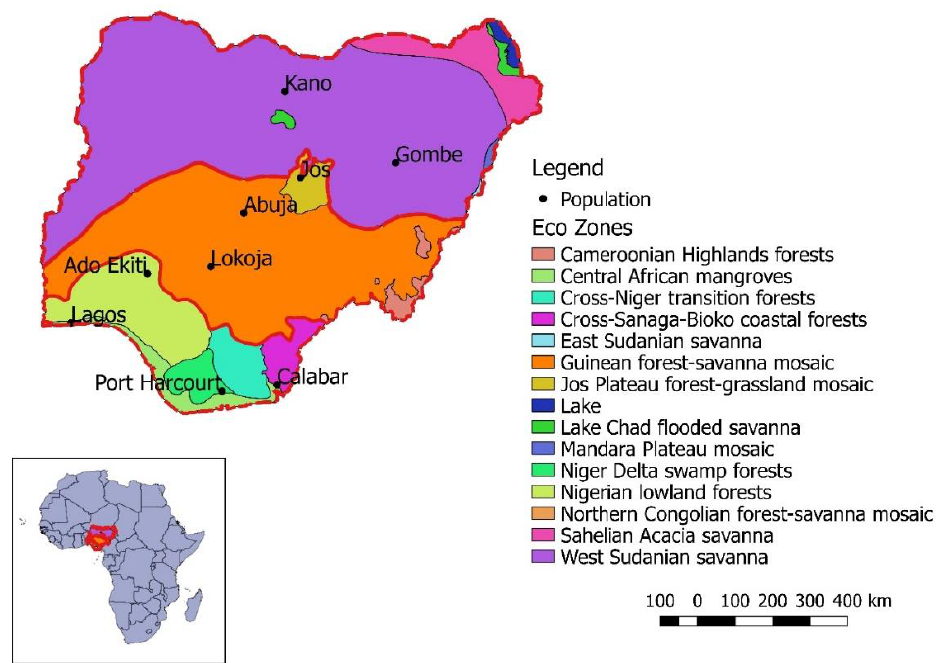
Figure 1. Geographical location and ecological zones of the study area (Nigeria) . The red color dashed boundary line shows the three main ecological zones boundaries which are the northern Sudan Savannah, the Guinea Savannah or “Middle Belt”, and the southern rainforest zone.